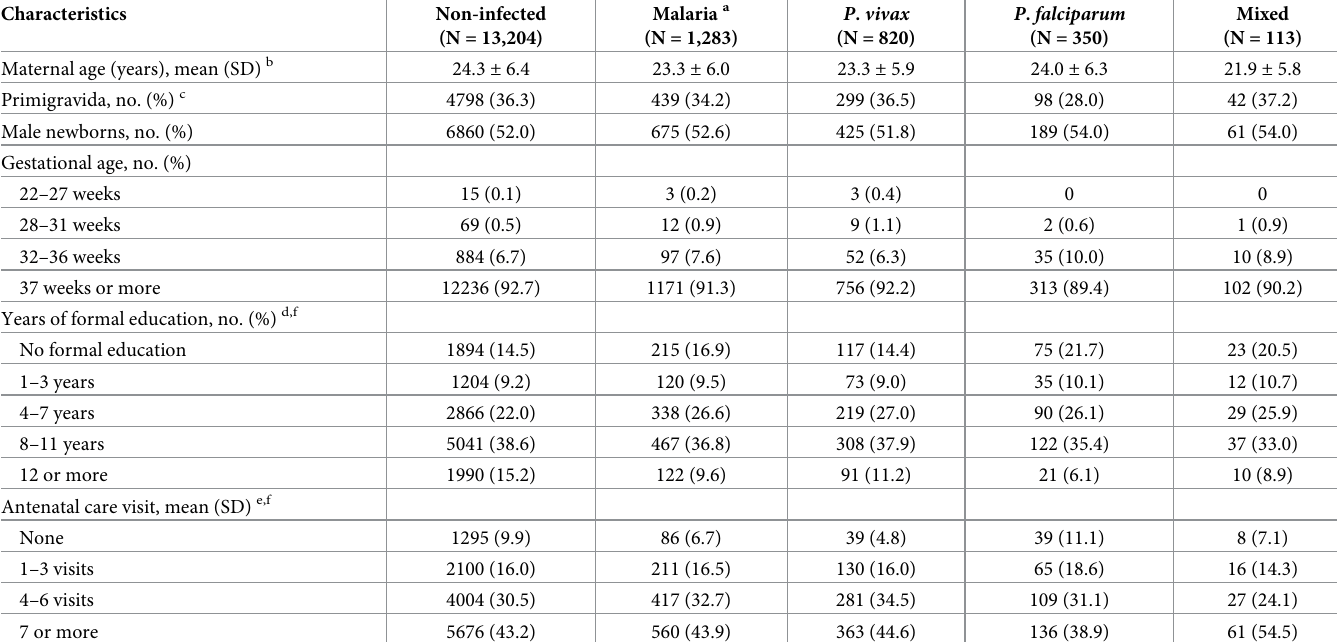
Table 1. Baseline characteristics of mothers at